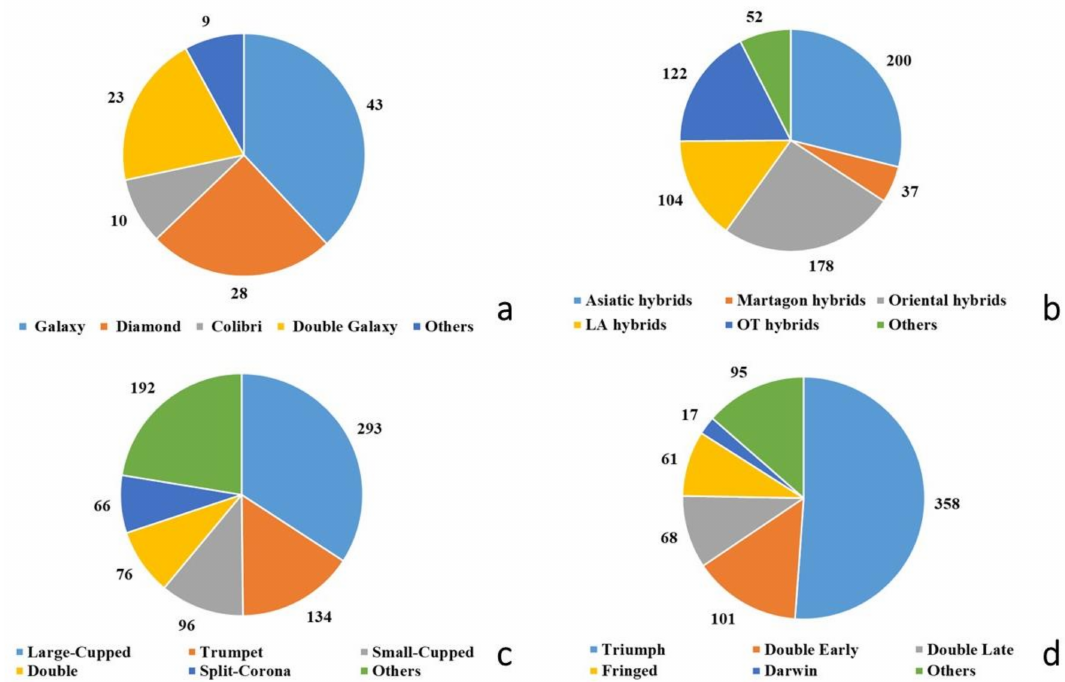
Figure 3. Number of cultivars in the different groups of the international horticultural classification, specific to each botanical genus, registered in authorised international registers during the last 5 years: ( a ) Hippeastrum (2015–2019) in the Dutch Royal General Bulb Growers’ Association (KAVB), Hillegom, the Netherlands; ( b ) Lilium (mid-2014 to mid-2018) in the Royal Horticultural Society (RHS), London, United Kingdom; ( c ) Narcissus (mid-2015 to mid-2020) in the RHS, London, United Kingdom; ( d ) Tulipa (2015–2019) in the KAVB, Hillegom, the Netherlands (the pie charts represent the authors’